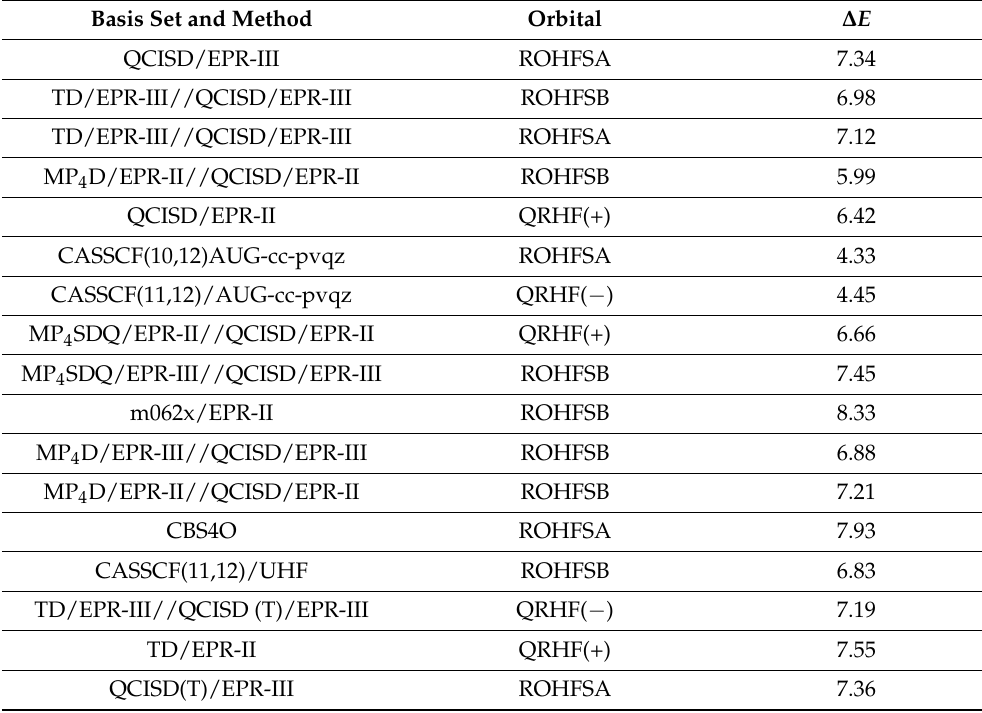
Table 5. ∆ E among the BNB ground states having linear symmetric R 1 = R 2 = 1.35 Å and